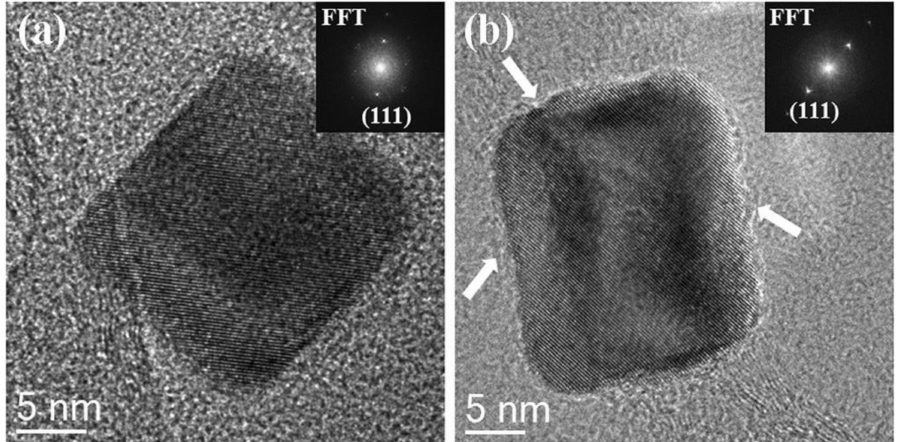
Figure 5. HR TEM images of palladium NPs after 2 h ( a ) and 55 h ( b ) of the reaction. White arrows indicate the sunken regions with steps and terraces. (Reproduced with permission from ref.